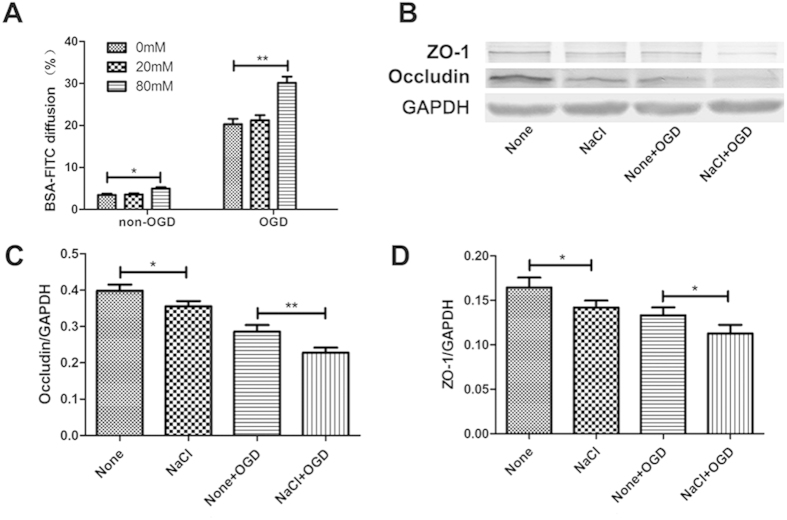
Excess salt intake accelerated OGD-induced BBB disruption associated with ZO-1 and Occludin down-regulation in vitro.(A) Confluent bEnd.3 cells grown on 24-well cell culture inserts with indicated concentrations of NaCl for 4 days, and then BSA-FITC addition together with 6 h OGD/non-OGD treatments were processed. The bar graph shows the statistical analysis of the BSA-FITC diffusion rate. The data represent are pooled results from three independent experiments. (*p < 0.05, **p < 0.01, ***p < 0.001). (B) Representative western blotting of ZO-1 and Occludin expression under high-salt and OGD conditions. The statistical analysis is shown in bar graphs (C,D). The data represent are pooled results from four independent experiments. (*P < 0.05, **P < 0.01). Values are mean ± SD.